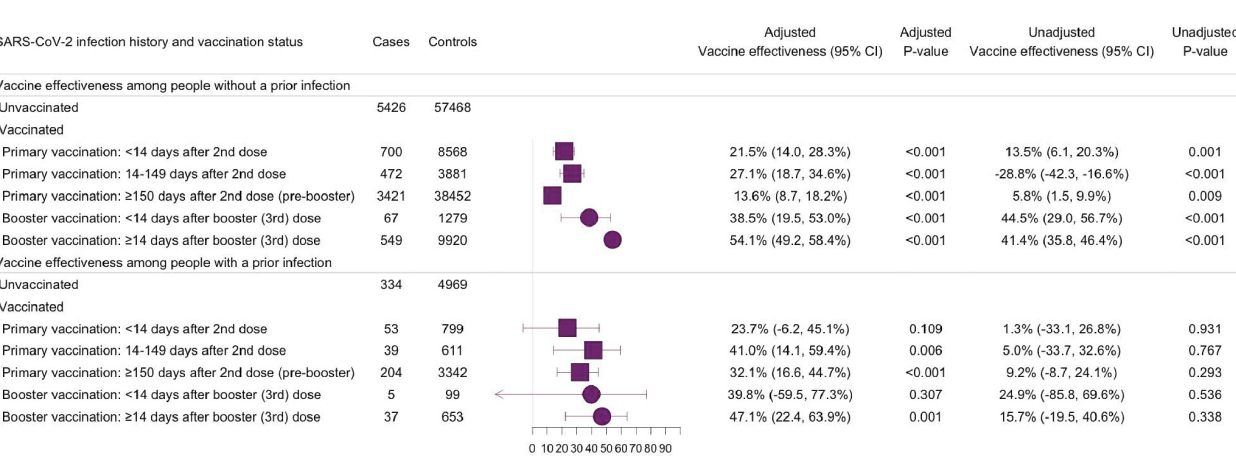
Fig 3. Effectiveness of primary and booster vaccination with COVID-19 mRNA vaccines against SARS-CoV-2 Omicron (BA.1 lineage) variant infections, stratified by the history of a documented prior SARS-CoV-2 infection. Forest plot depicting vaccine effectiveness against Omicron (lineage BA.1) infections for US-approved mRNA vaccines (BNT162b2 and mRNA-1273) among people with and without a documented prior infection. A documented prior infection was defined as a positive RT-PCR or rapid antigen test at least 90 days before the included test. Omicron (lineage BA.1) infection was defined as the presence of SGTF defined as ORF1ab Ct < 30 and S-gene–ORF1ab � 5, or ORF1ab < 30 and S-gene � 40. Vaccine effectiveness was estimated as one minus the OR from a model adjusted for date of test, age, sex, race/ethnicity, Charlson comorbidity score, number of nonemergent visits in the year prior to the vaccine rollout in Connecticut, insurance status, municipality, and SVI of residential zip code in all analyses and time between testing and last documented prior infection in analyses of people with a documented prior infection. COVID-19, Coronavirus Disease 2019; OR, odds ratio; RT-PCR, reverse transcription PCR; SARS-CoV-